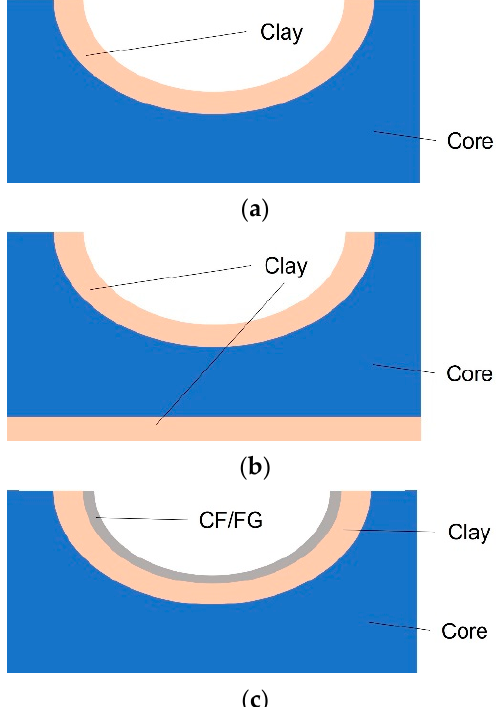
Figure 1. Schematic representation of hybrid structures that can be manufactured using the proposed methodology: ( a ) Standard mould with a core and external clay; ( b ) Sandwich structure with external coatings and a dense core; ( c ) Standard mould with CF (Carbon Fiber) or FG (Fiber Glass) deposition over the